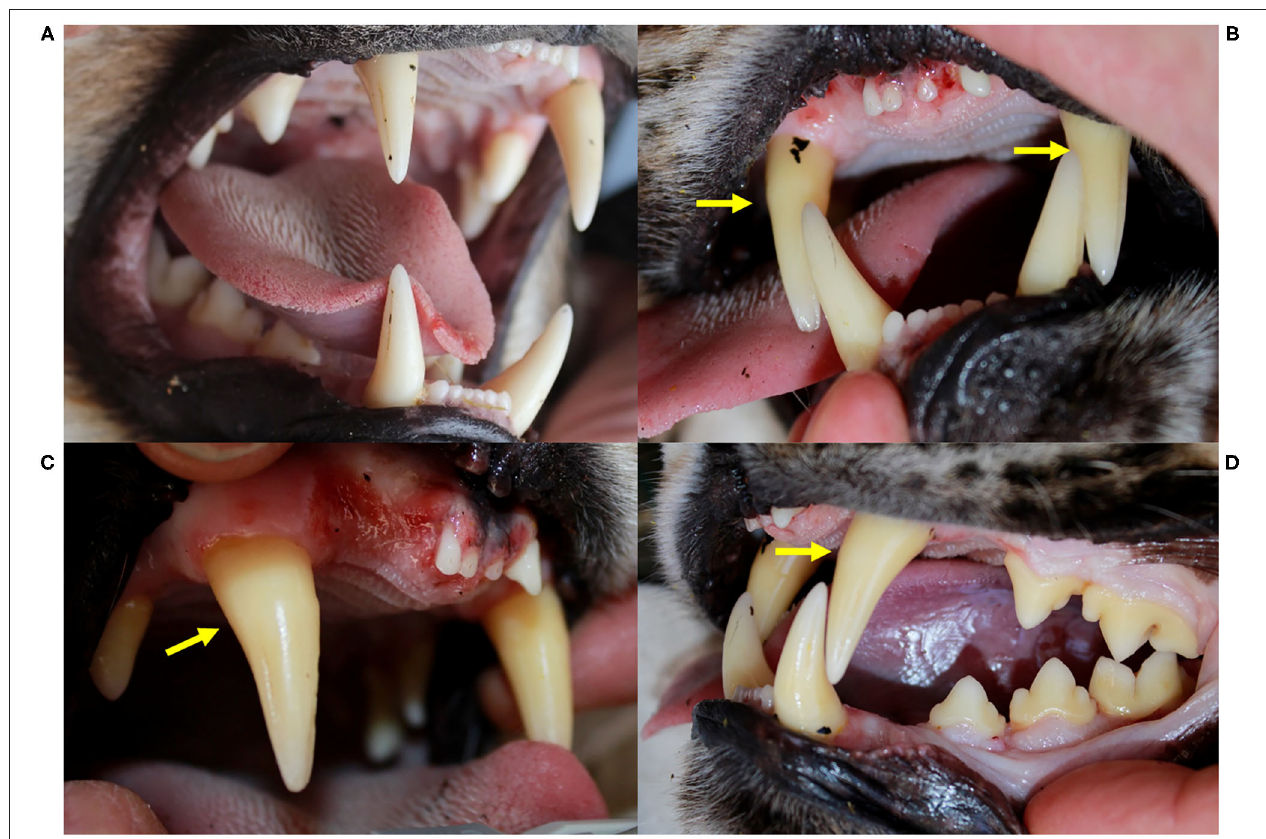
FIGURE 2 | Oral health status, Eurasian lynx ( Lynx lynx ), ADIN; (A) Left fronto-lateral view of the opened mouth, 1st capture (2013, FIV-negative by Western blot): complete permanent dentition, intact gingiva. (B) Frontal view, (C) Left fronto-lateral view, and (D) Left lateral view of the opened mouth, 2nd capture (2016, FIV-positive by Western blot): missing upper incisors (103, 202) with multifocal spots of mild to severe gingivitis without obvious extraction wounds, intact mandibular incisors and intact